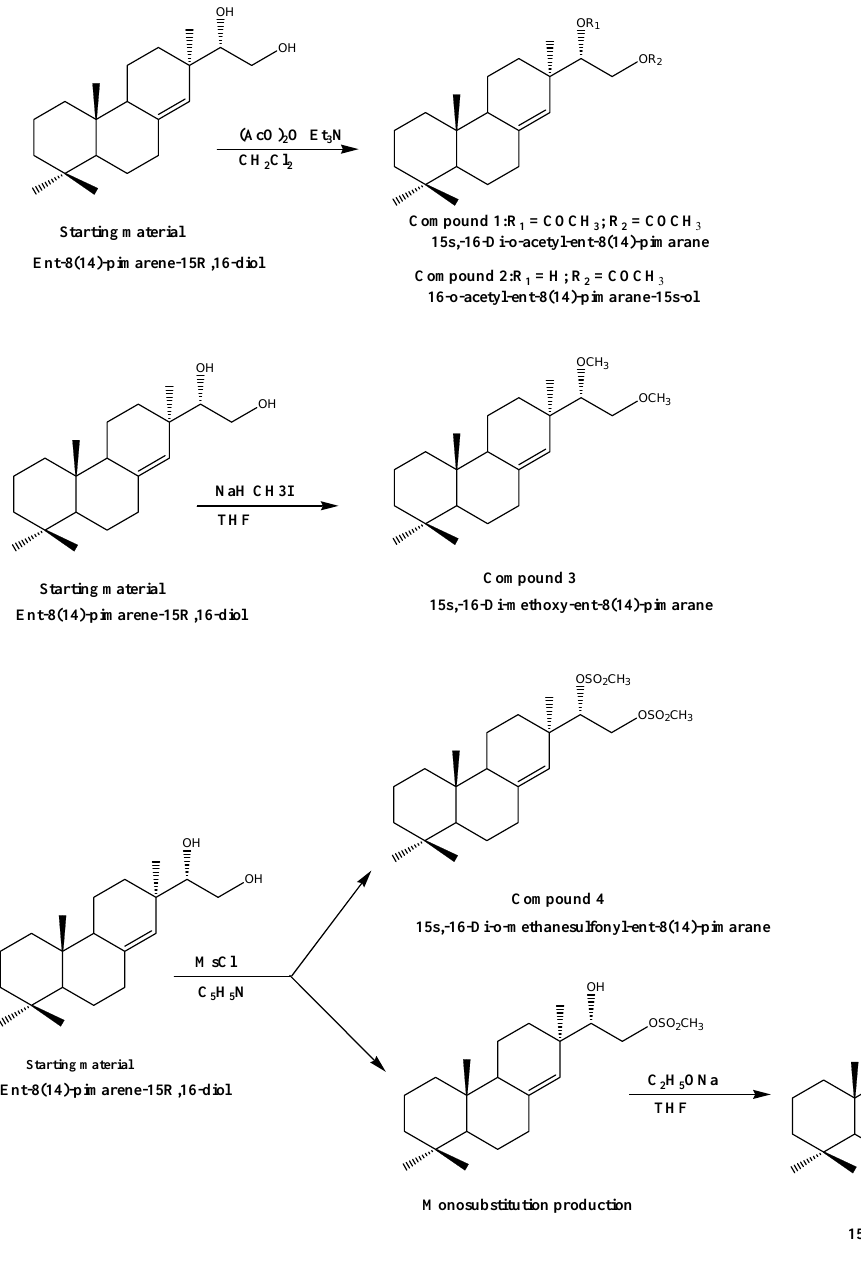
Scheme 1. Synthesis of the investigated